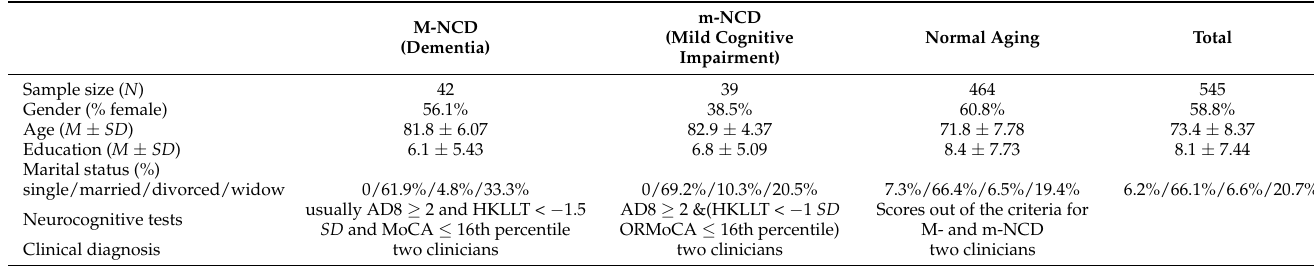
Table 2. Sample demographics and diagnostic criteria for different cognitive